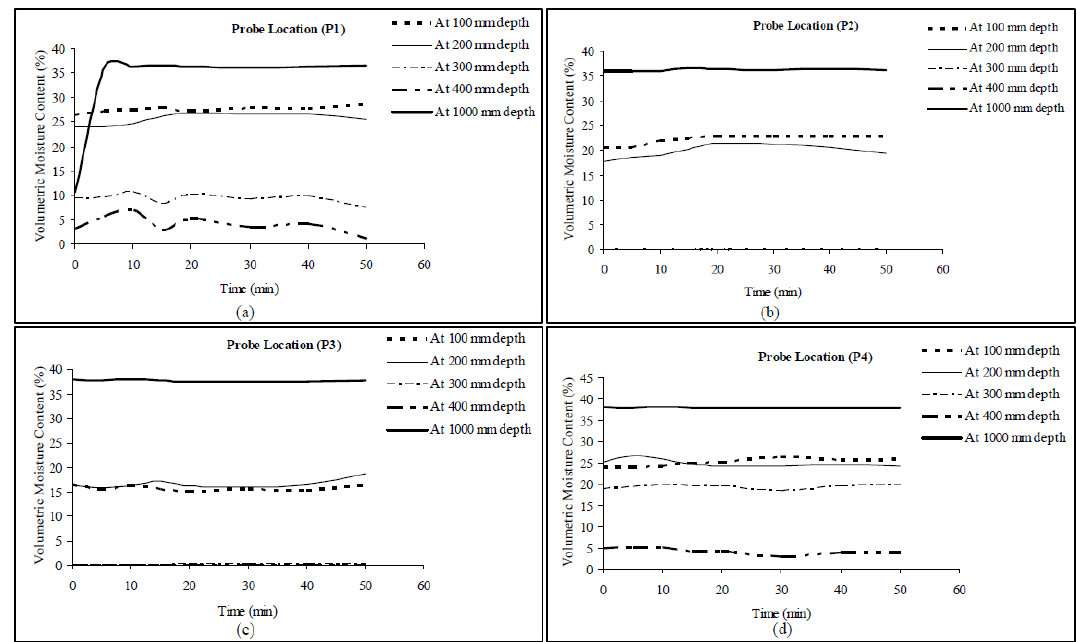
Figure 7. ( a – d ) Soil moisture variations at experimental hillslope plot.